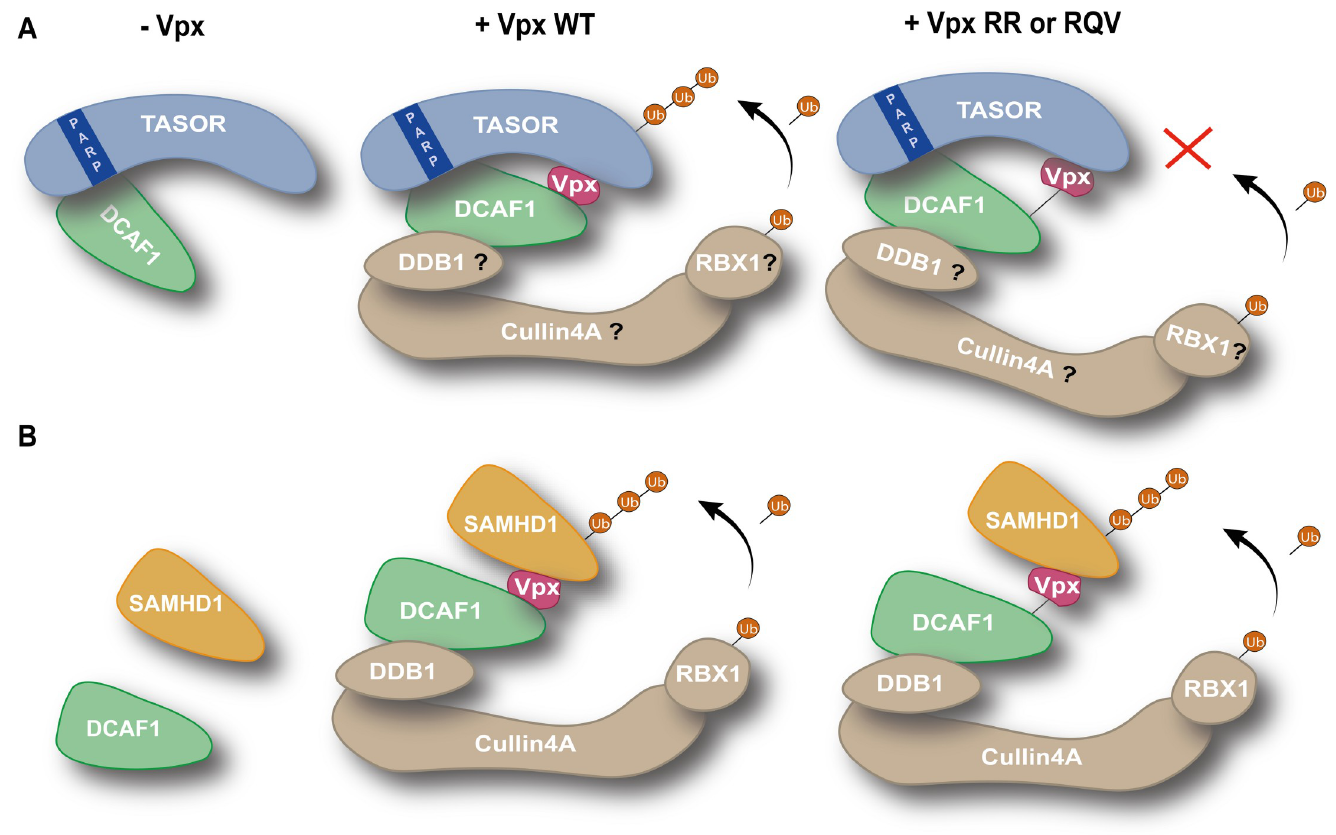
Fig 7. Working model. ( A ) TASOR antagonism. In the absence of Vpx, TASOR can be found in association with DCAF1. TASOR PARP- like domain is involved in this interaction. By co-binding to TASOR and to DCAF1, Vpx WT would create another indirect contacting point between TASOR and DCAF1, increasing the interaction affinity between TASOR and DCAF1. Structural conformation changes would trigger the degradation of TASOR by the whole ubiquitin ligase complex and TASOR poly-ubiquitination. Vpx RR or Vpx RQV mutants bind TASOR but present a lower affinity for DCAF1, which is represented by a black line; in turn, the interaction affinity between TASOR and DCAF1 is not sufficient to orientate the whole ubiquitin ligase complex in order to trigger TASOR degradation. Of note, whether TASOR-DCAF1 and TASOR-Vpx interactions are direct or not is unknown. ( B ) SAMHD1 antagonism. SAMDH1 does not interact with DCAF1 in the absence of Vpx. Vpx bridges the two cellular proteins, allowing the recruitment of the whole ubiquitin ligase complex, SAMHD1 ubiquitination and degradation. Vpx RR or RQV are both able to induce SAMHD1 degradation, despite their apparent low binding affinity for DCAF1.